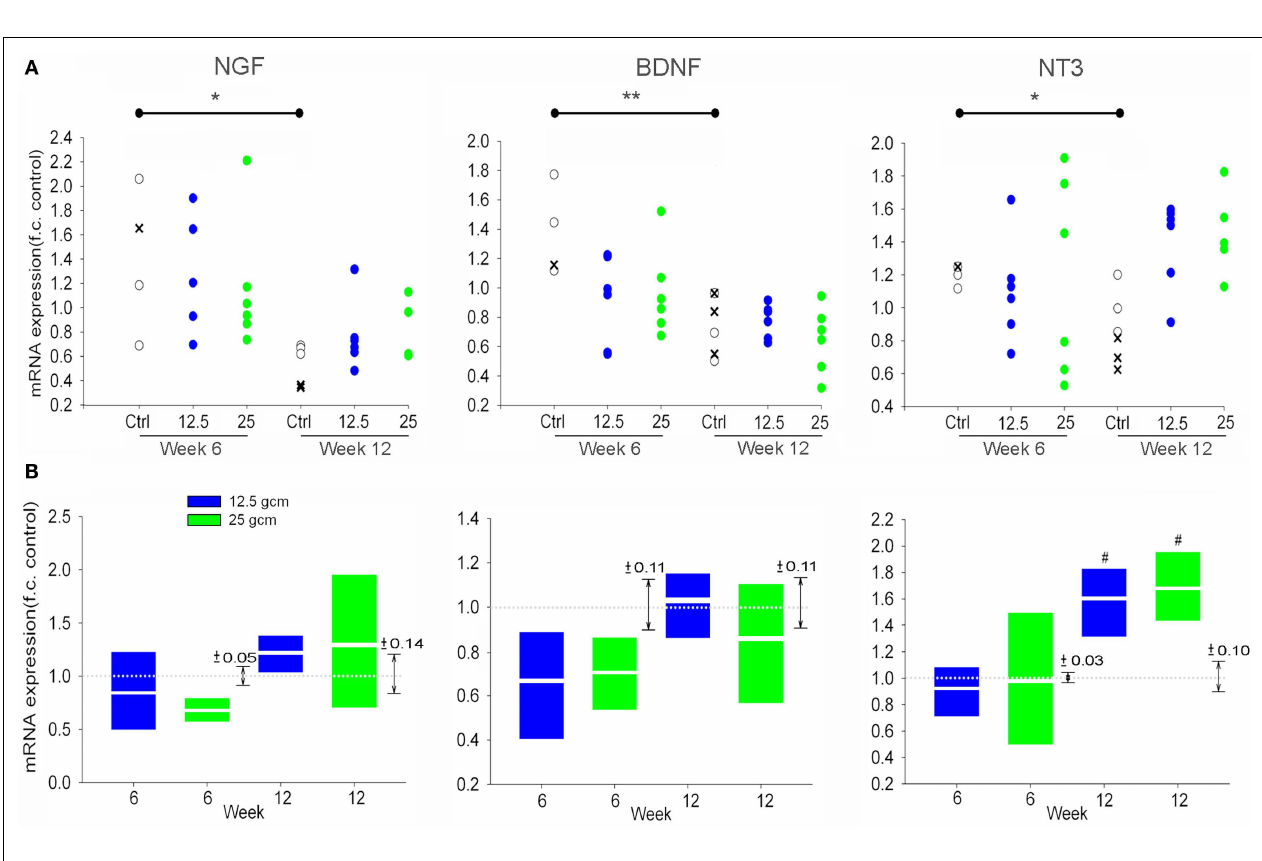
12weeks after receiving either 12.5gcm (blue) or 25gcm (green) NYU contusion injury to spinal cord at vertebral levelT9, relative to their respective age-matched control groups . X axis denotes weeks post injury.White lines in box-plots indicate group mean. Dotted gray lines indicate expression level of controls (normalized to 1), with ± SEM indicated by the vertical arrows to the right of each time point pair. # p < 0.05 from